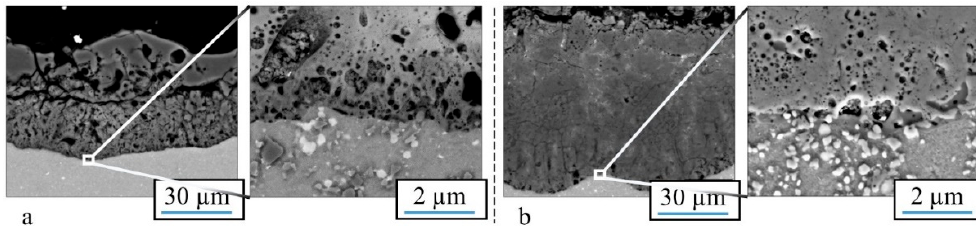
Figure 5. Cross section of the oxide produced in a PEO process on a SiC- ( a ) and a Al 2 O 3 - ( b ) particle- reinforced aluminum alloy of the 2000 series [57]. (Reprinted from [57]. Copyright from 2016 IOP)